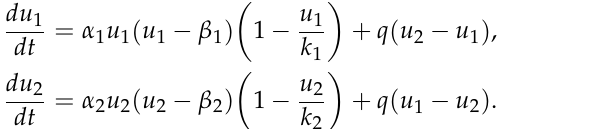
Similarly, in figure 3.10, the only steady state for q = 1 . 5 is the trivial one ( u 1 ,u 2 ) = (0 , 0) .